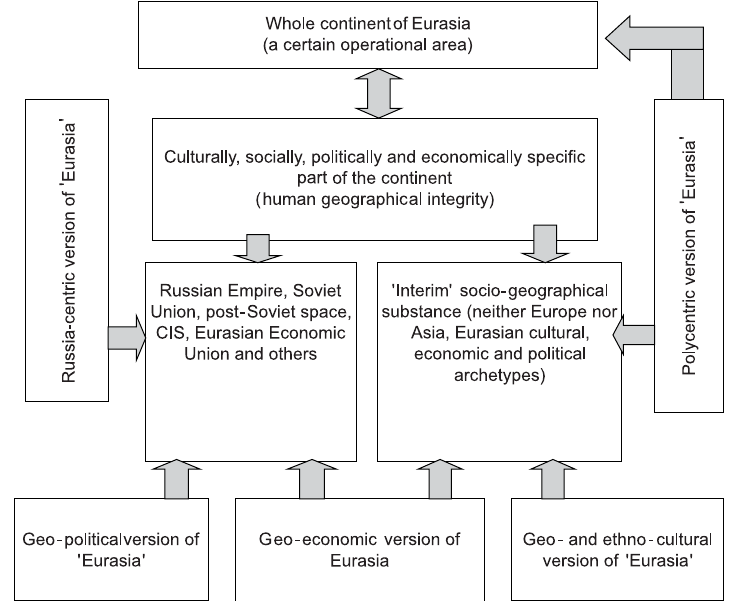
Fig. 1. Invariance of the category of